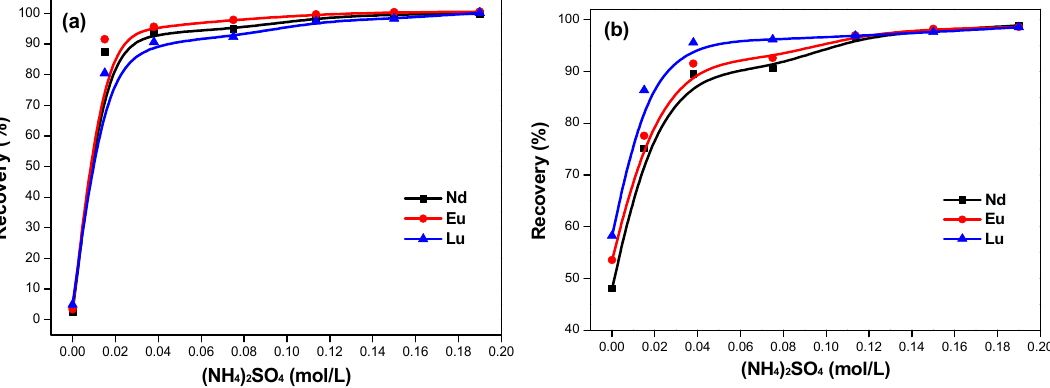
Figure 10. Influence of pH on the recovery of Nd 3+ , Eu 3+ and Lu 3+ from halloysite ( a ) and illite ( b ). (Contact time = 240 min, (NH 4 ) 2 SO 4 concentration = 0.11 mol/L.)